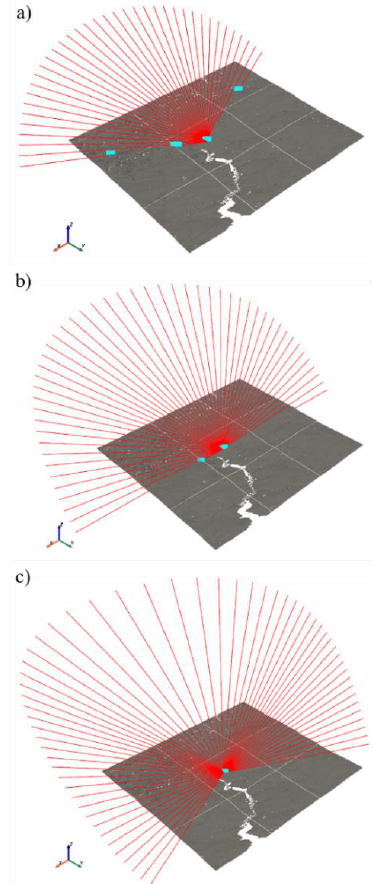
Figure 7. Sun rays during daylight (red lines) represented in the 2x2 km roundabout grid for a) winter solstice, b) equinoxes, c) summer solstice. river’s vision field in the horizontal plane is indicated with blue arrows (referring to vector 5).